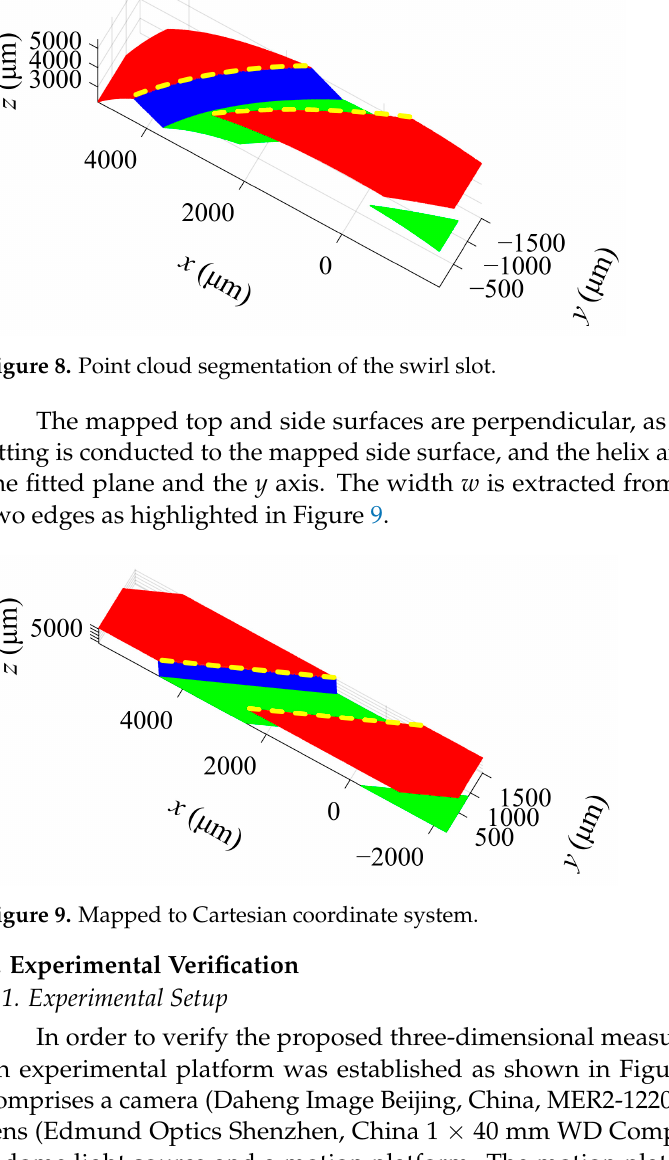
Figure 7. Swirl slot of the inner part of the nozzle.